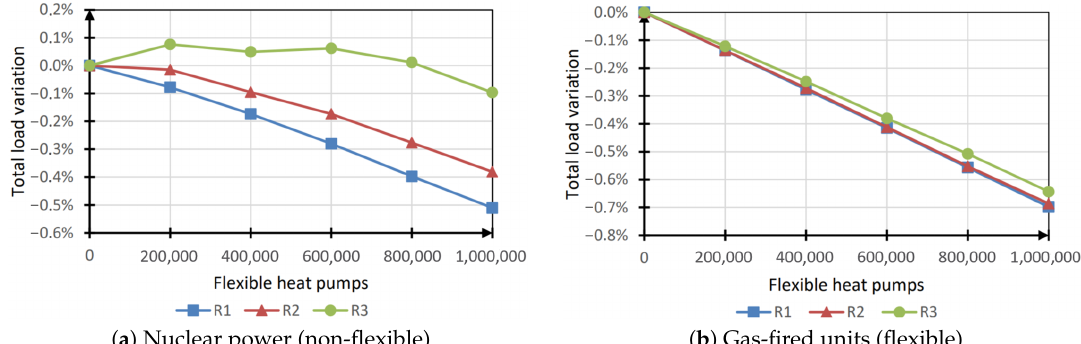
Figure 10. Total load variation (heat pumps).